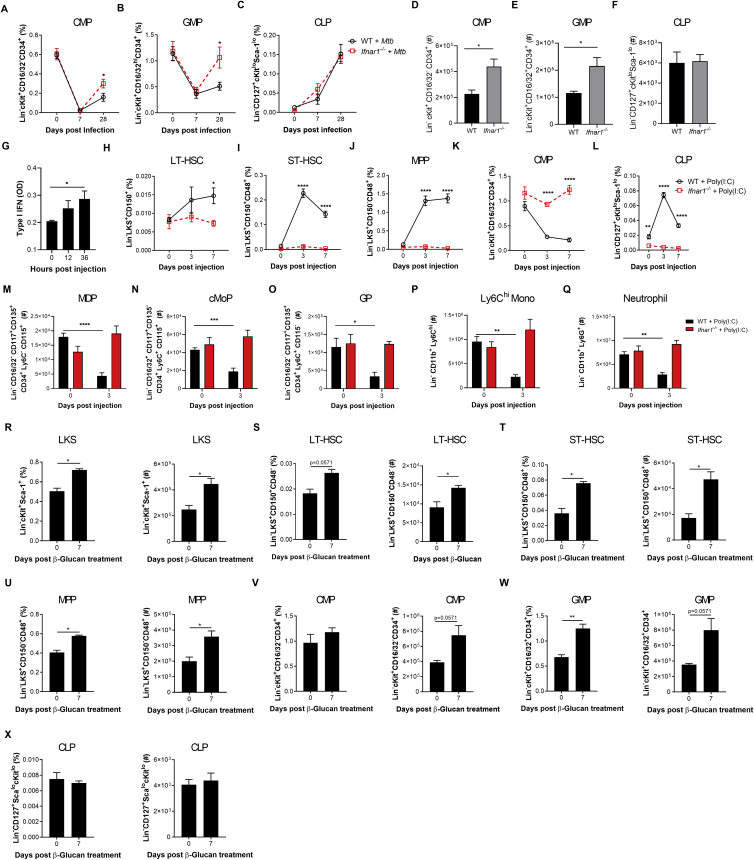
IFN-I Signaling Impairs Myelopoiesis, Related to Figure 4(A-C) WT and Ifnar1−/− mice were infected with 1x106Mtb-iv. Kinetics of the frequencies among single viable BM cells of CMP (A), GMP (B) and CLP (C). (D-F) mice were infected with Mtb via the aerosol route. Percentages of CMP (D), GMP (E) and CLP (F) in the BM at day 60. (G) Active IFN-I was measured in the BM collected after 12, 24, and 36 hours after Poly (I:C) treatment. (H-Q) WT and Ifnar1−/− mice were treated with Poly (I:C), or PBS, at day 0, 2, 4, 6. Frequencies among single viable BM cells of LT-HSC (H), ST-HSC (I), MPP (J), CMP (K) and CLP (L) at days 0, 3 and 7, as well as the total number of MDP (M), cMoP (N), GP (O), Ly6Chi monocytes (P) and neutrophils (Q) at day 3 post-Poly-(I:C) treatment. (R-X) WT mice were treated with β-glucan at day 0 and day 3. Frequencies among BM cells (left panel) and total cell counts (right panel) of LKS (R), LT-HSC (S), ST-HSC (T), MPP (U), CMP (V), GMP (W) and CLP (X) in PBS (day 0) or β-glucan i.p. at day 7 post-treatment. Differences determined by Two-way ANOVA followed by Sidak’s Multiple Comparisons Test in A-C, H-Q, Two-Tailed Student’s T-Test in D-F, One-way ANOVA followed by Dunnett’s Multiple Comparisons Test in G and Non-Parametric Mann-Whitney Test R-X.